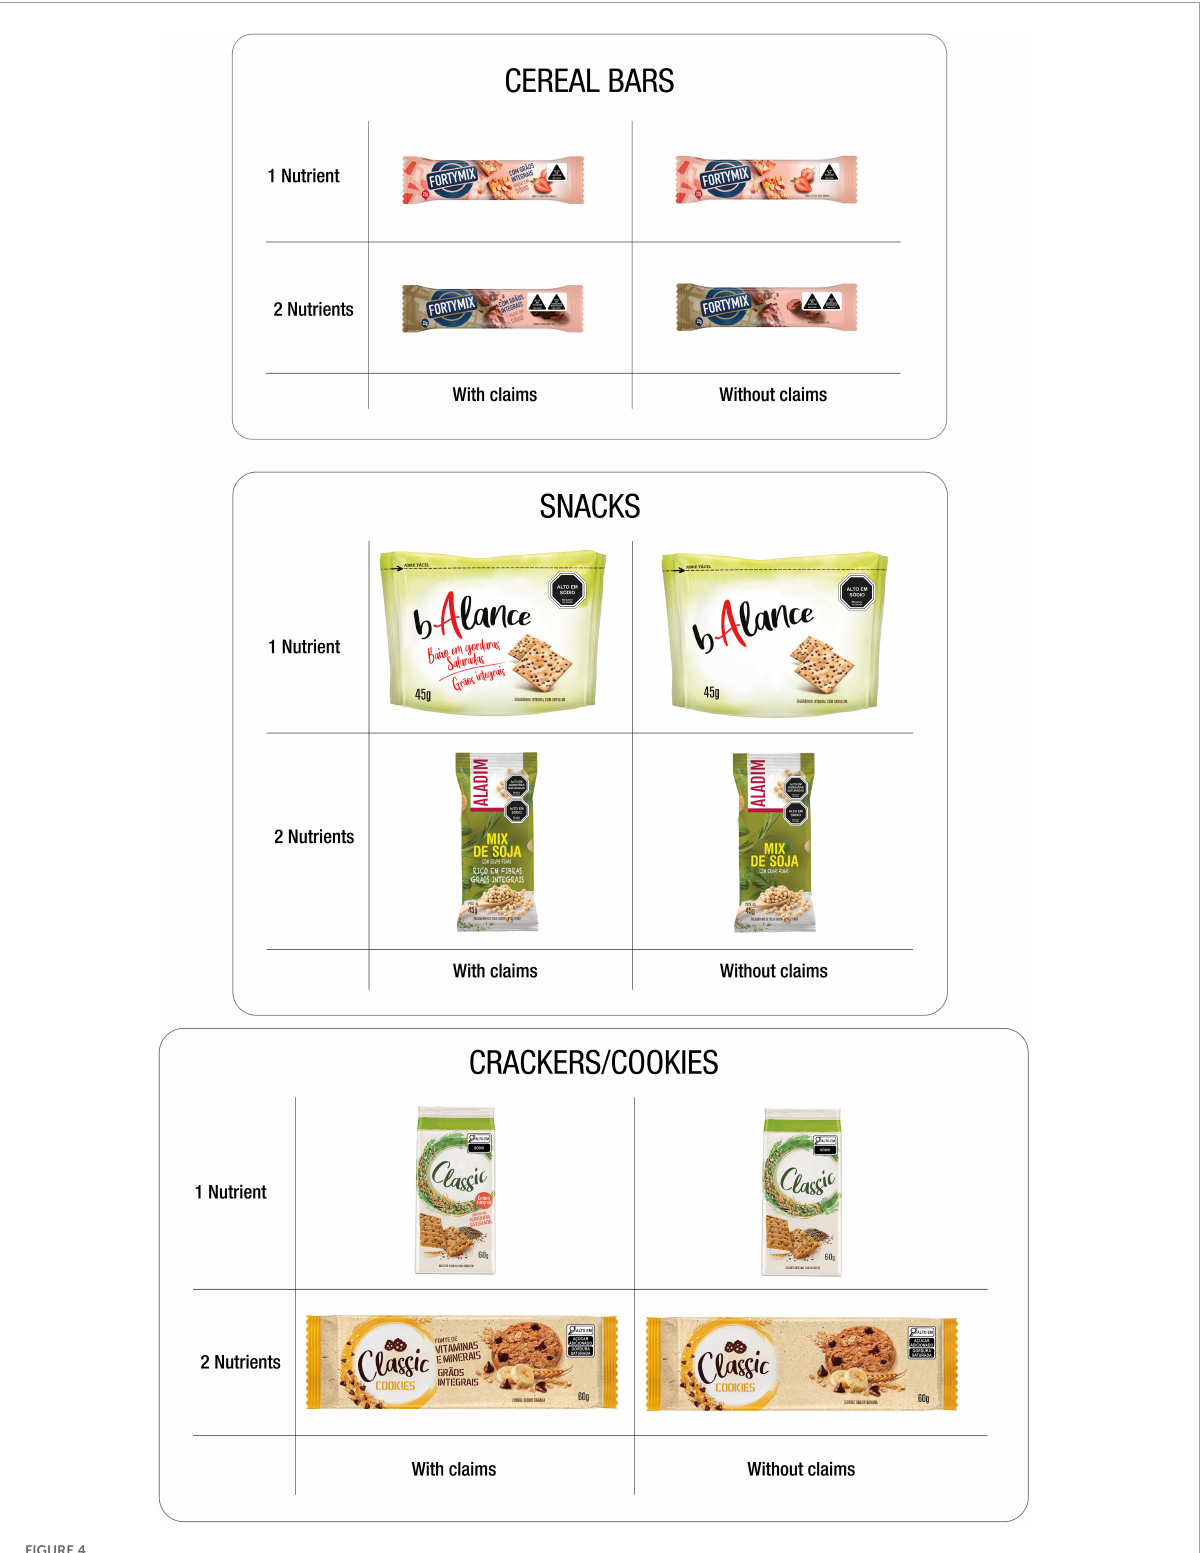
FIGURE4 Combination of factors considered for label development: food category (cereal bars, snacks, and crackers/cookies); type of product (containing 1 or 2 nutrients in excess); nutrition claim (present vs. absent).